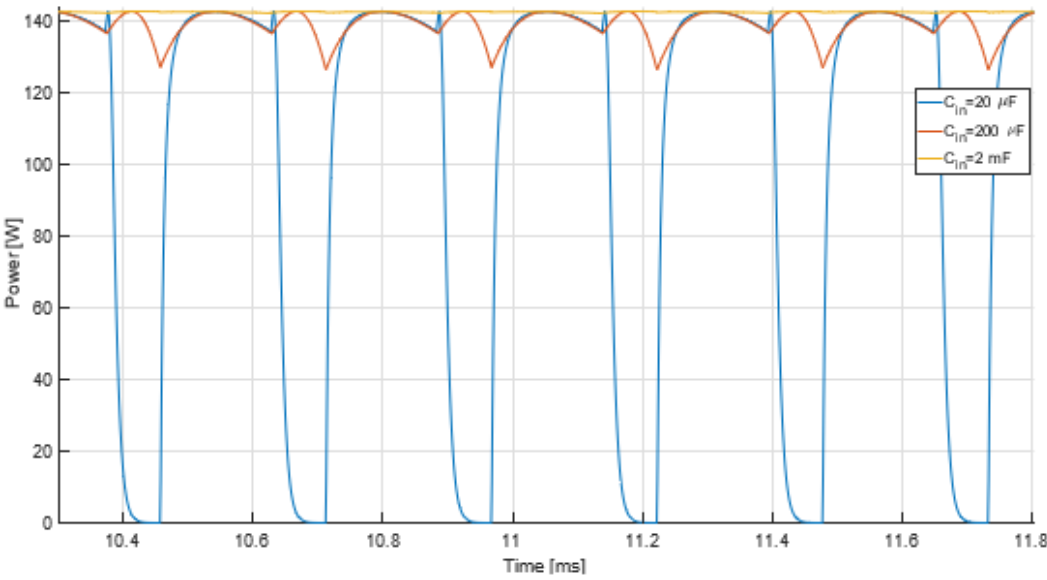
Figure 31. Simulink model of the MPPT with a solar array, buck converter, battery and load.